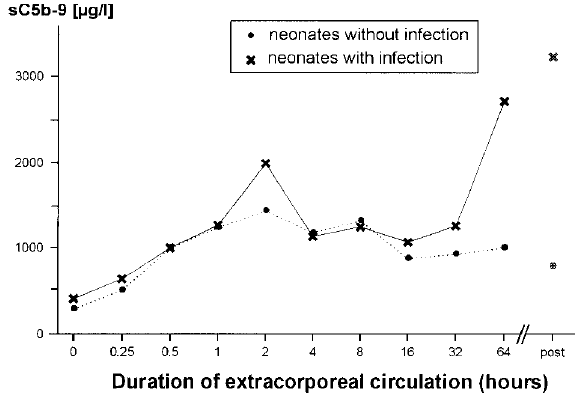
FIG. 4. Mean sC5b-9 concentration of neonates without secondary infection during ECMO ( d , patients 1, 4, 5, and 6) and in neonates with secondary infection during ECMO (x, patients 2 and 3). Post, 12h after